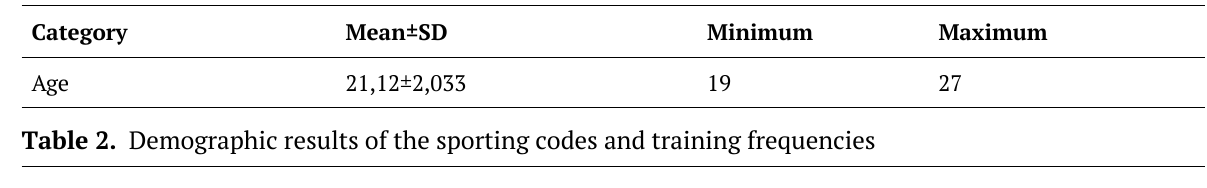
Table 1. Age-related statistics